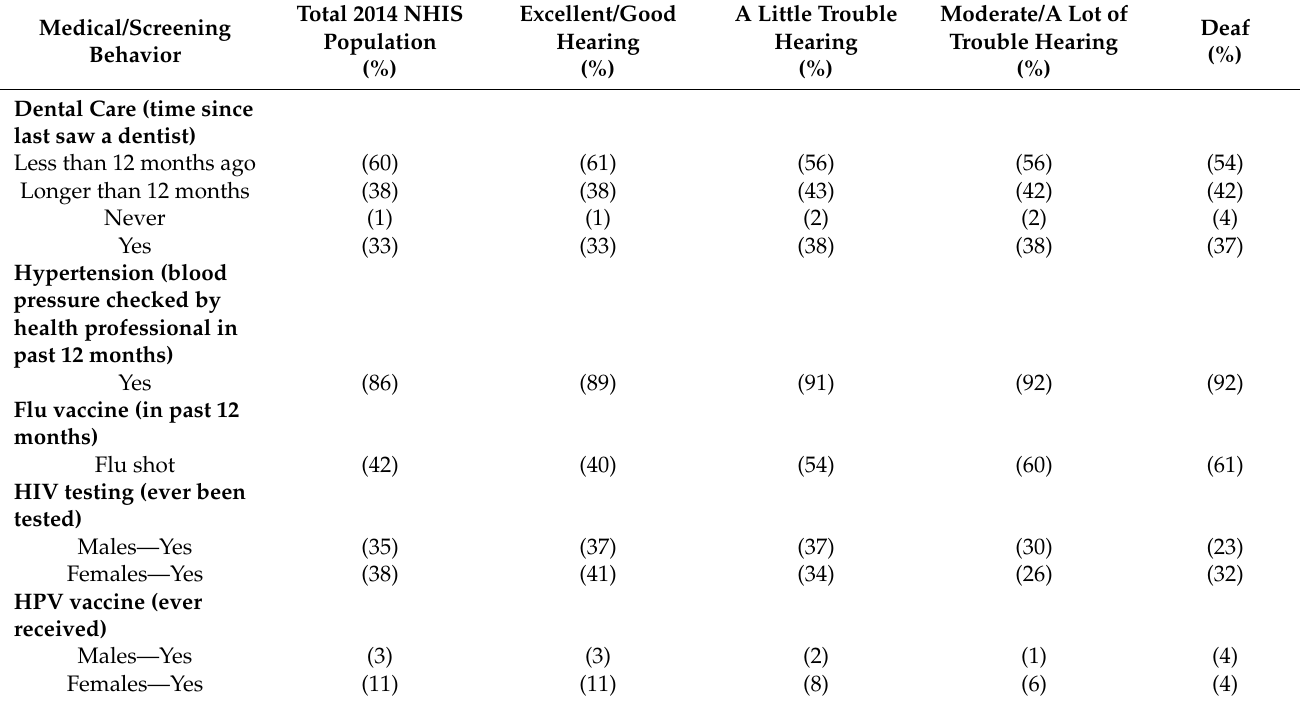
Table 5. Medical/screening behaviors by hearing level: All NHIS participants (2014).